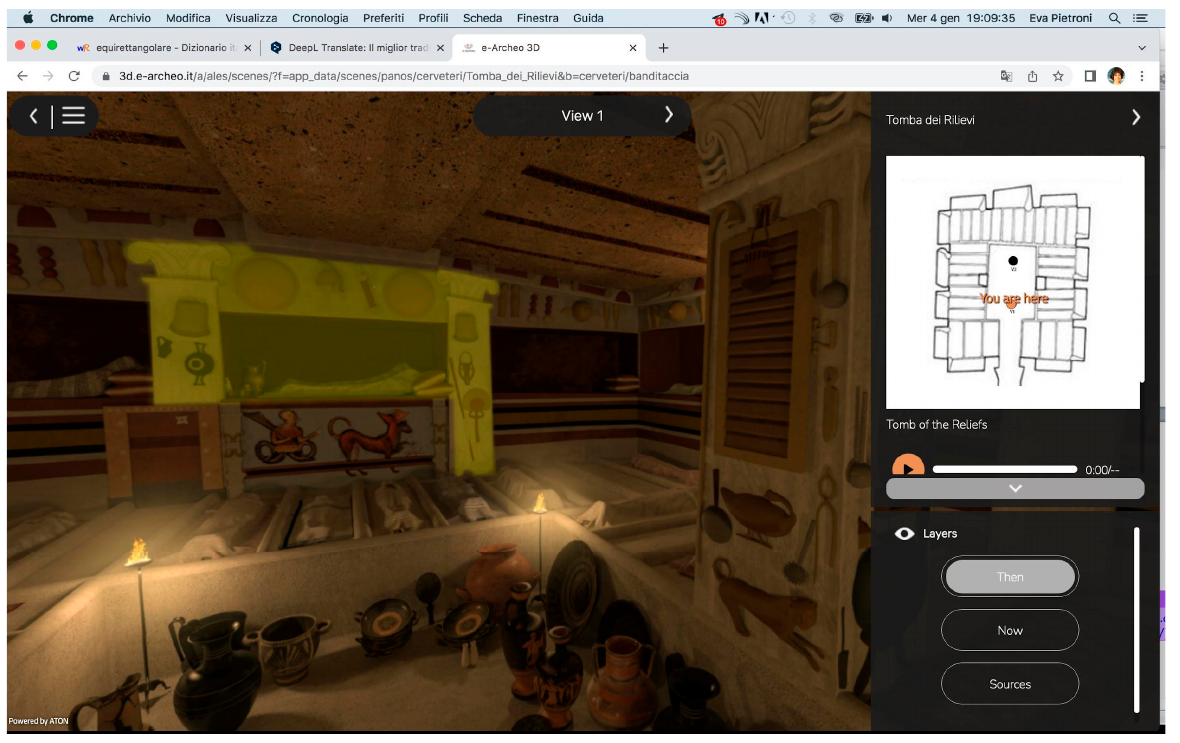
Figure 2. Virtual reconstruction of the Tomb of Reliefs in Cerveteri, 360° interactive image, with semantic map applied in order to show the interactive elements that can be deepened. Virtual reconstructions have offered the opportunity not only to simulate ancient urban and architectural contexts but also to contextualize objects coming from the site and today preserved inside museums (Figure